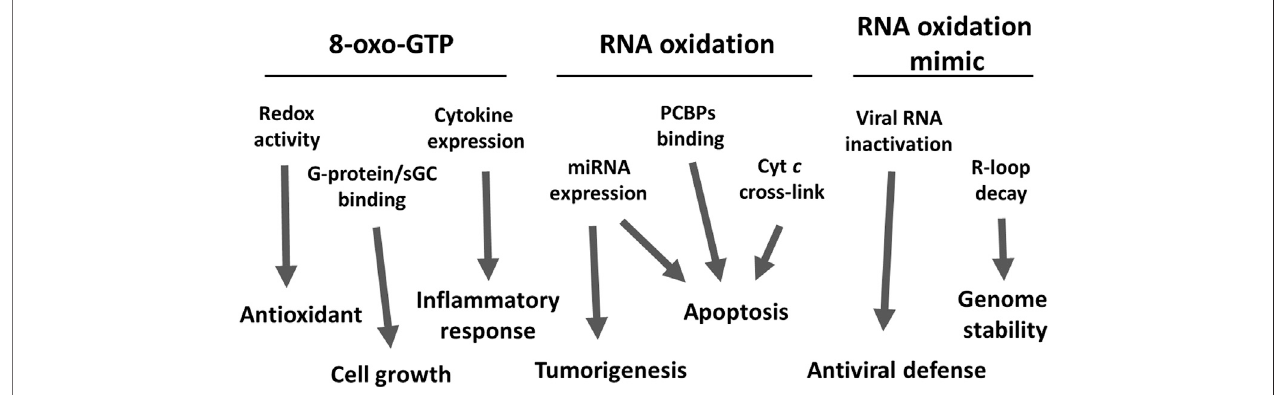
FIGURE1| AschematicdiagramofthepotentialrolesofoxidizedRNA.ThreetypesofoxidizedRNA,free8-oxo-GTP,oxidizedRNA,andtheequivalentlymodi fi ed RNA modulate several cellular functions and signaling pathways. The possible effects of those modulations, but not limited to are also represented. The detailed mechanisms are described in the text.